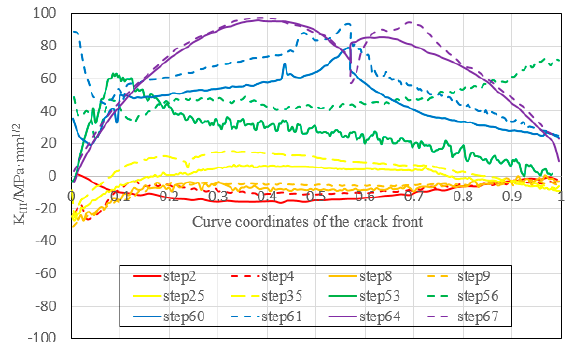
Figure 19. K III evolution of characteristic points ( K equ + SERR).